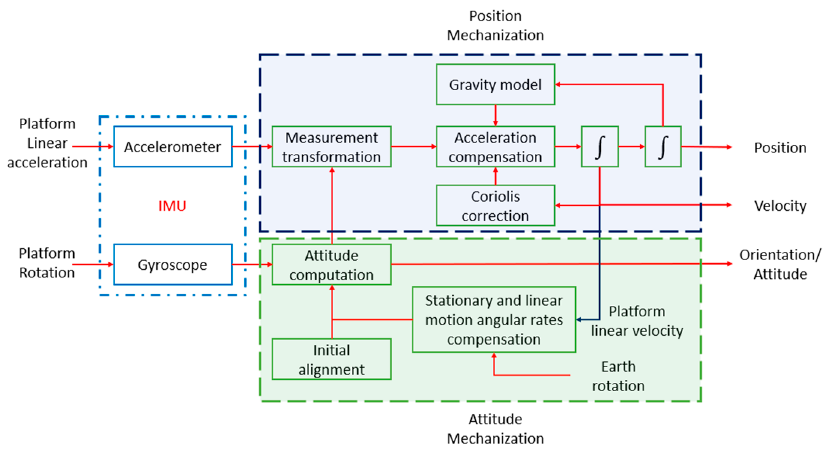
Figure 5. Block diagram of Dead Reckoning